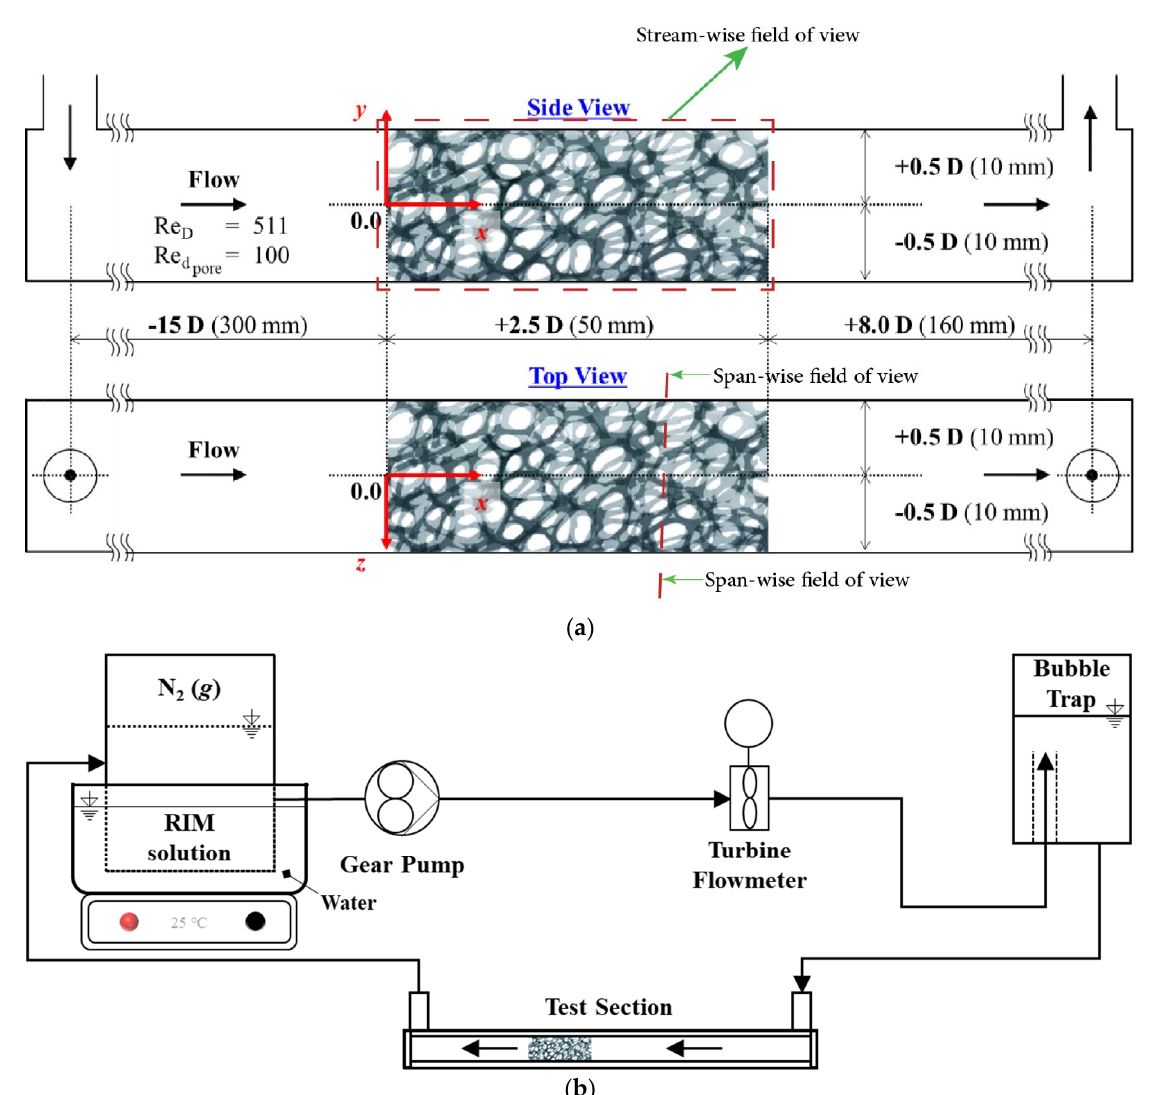
Figure 3. Experimental setup configuration: ( a ) test section details; ( b ) overall setup configuration.